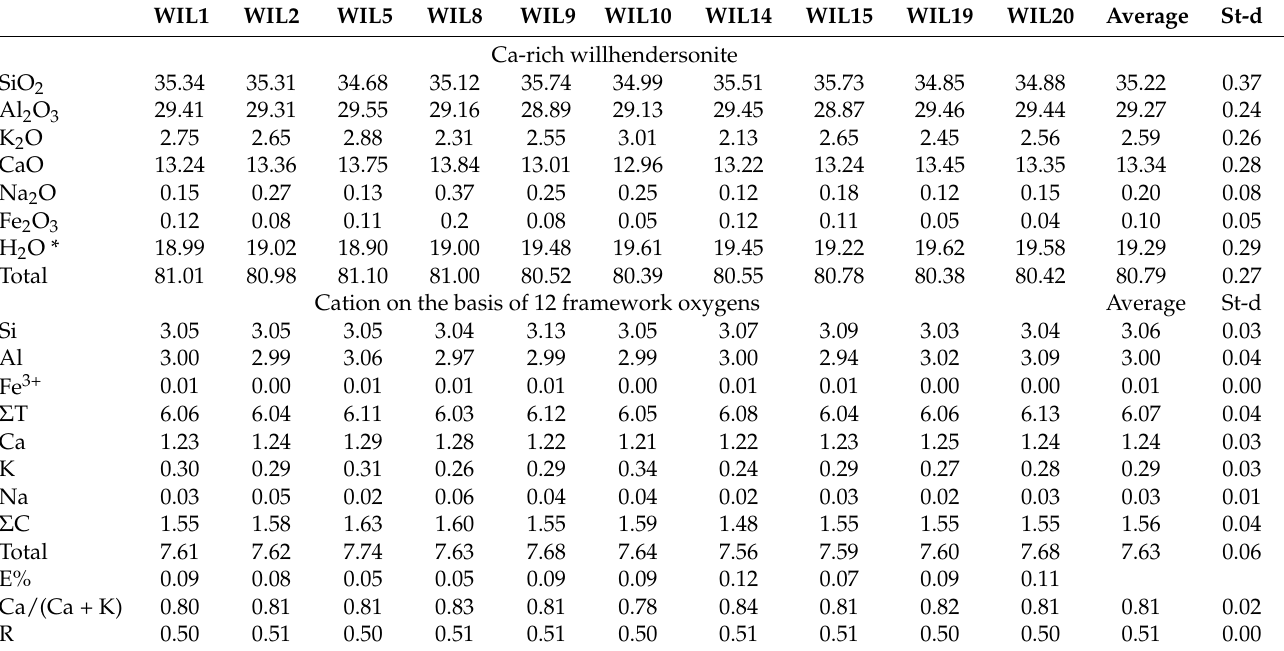
Table 2. Representative chemical compositions of Ca-rich willhendersonite from Lessini Mounts. * The H 2 O content is calculated by difference to 100; Mg, Sr, and Ba were checked but were always below the detection limit; E% is the balance error of the electrical charges: [Al − (K + 2Ca)]/(K + 2Ca); R is the tetrahedral content (Si/(Si + Al)) and St-d is standard deviation.